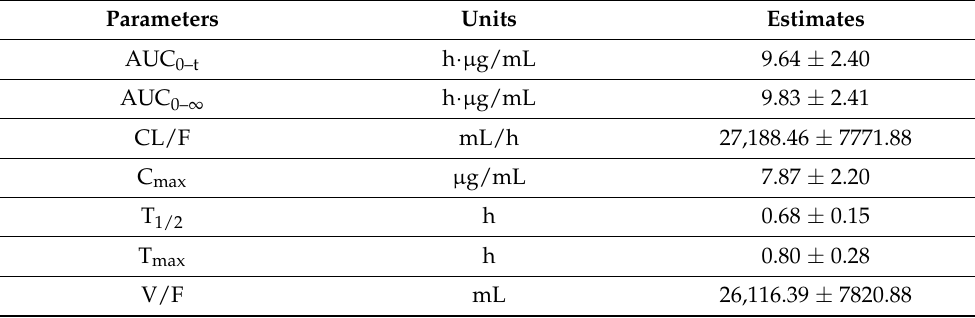
Table 2. Estimated pharmacokinetic parameters of cefaclor by non-compartmental analysis after a single oral administration of a 250 mg cefaclor capsule (mean ± SD, n =